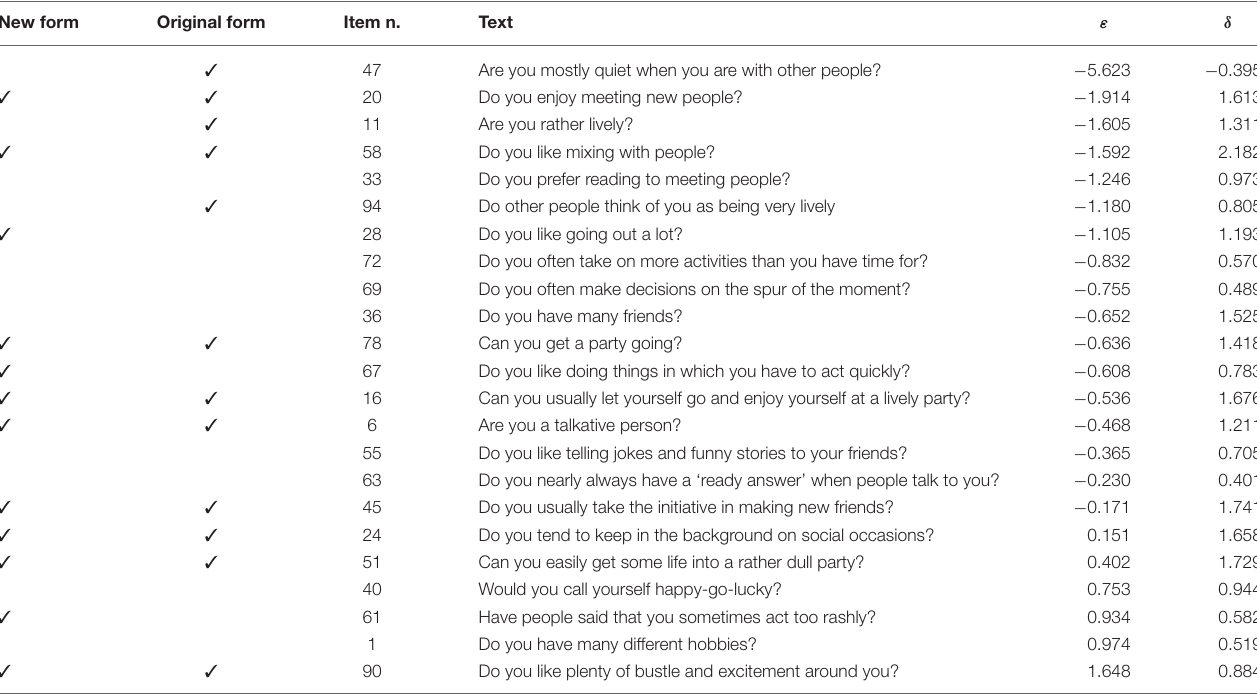
TABLE 2 | Easiness ( ε ) and discrimination ( δ ) parameters for the 23 items of the Extraversion scale. New